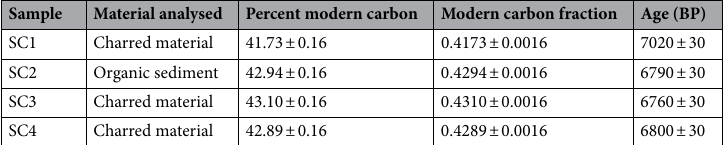
Table 1. Radiocarbon dating results for samples from the Shuangyu slackwater deposit.